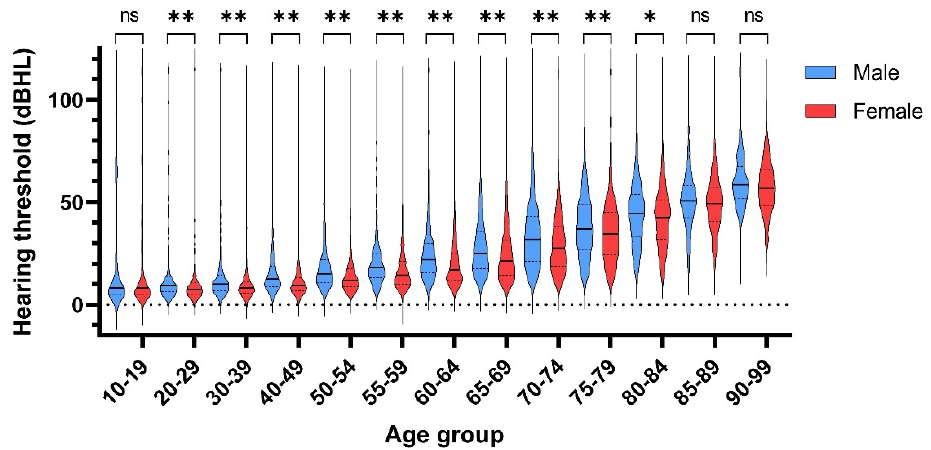
Figure 3. Gender- and age-specific violin plots of hearing thresholds. Hearing thresholds increased with age, and there were significant differences between males and females from their 20s to early 80s. The upper-dashed, solid, and lower-dashed horizontal lines in each dispersion envelope indicate the 75 percentile, the median, and the 25 percentile, respectively. The widths of the violin plots depict distribution density of hearing thresholds. The medium level of smoothing was used in GraphPad for the distribution density. *: p < 0.05, **: p < 0.01, ns: not significant. The percentages of participants in the five WHO grades (Grades 0–4) [18] of